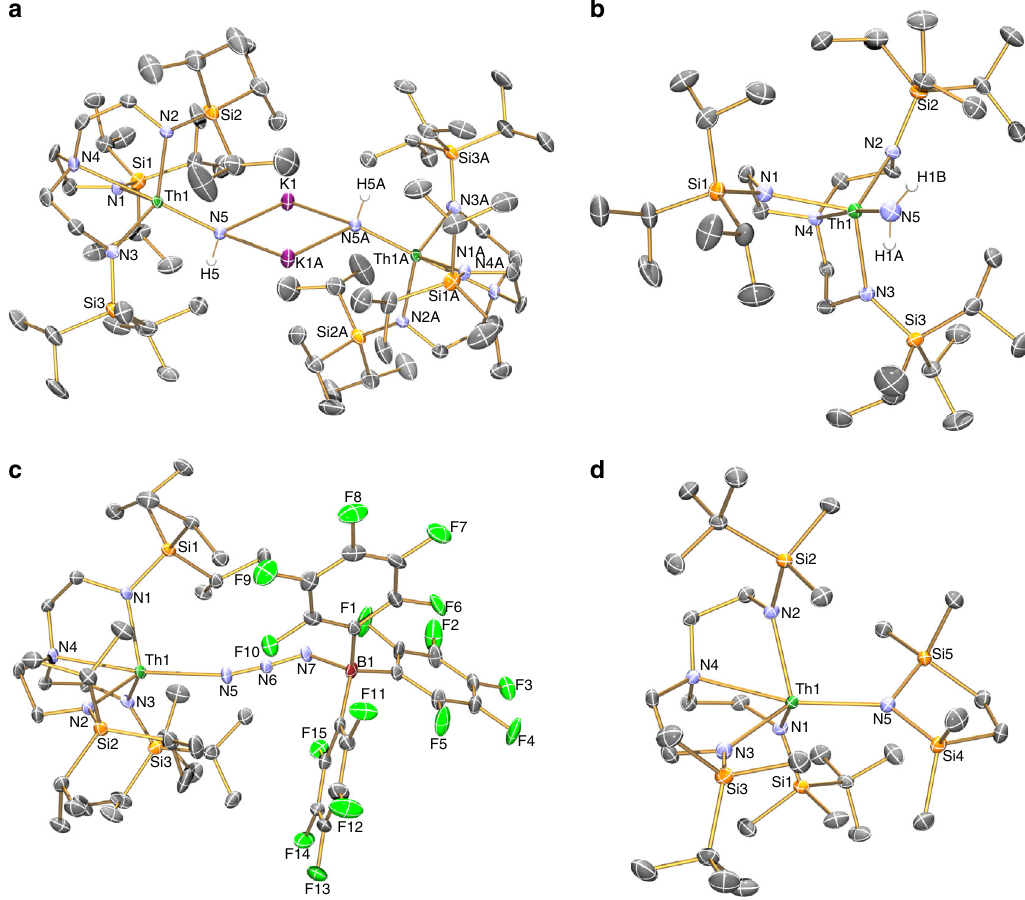
Fig. 2 Molecular structures of 4K , 5 , 6 and 10 with selective labelling. a the parent imido dimer 4K . b the parent amide 5 . c the borane-capped azide 6 . d the amide-heterocycle 10 . The data for these complexes were collected at 150 K, displacement ellipsoids are presented at 40% probability and non-imido hydrogen atoms and minor disorder components are omitted for